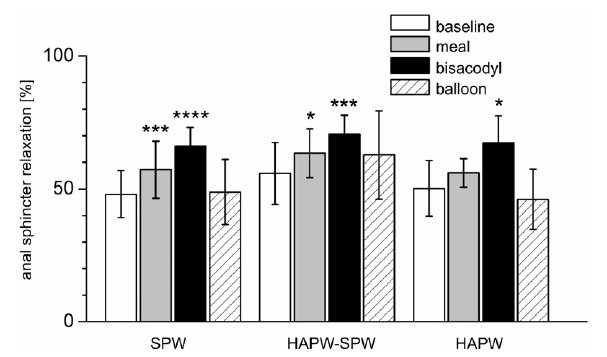
FIGURE 6 | Relaxation of the anal sphincters associated with different motor patterns and in different conditions. Shown is the relaxation of the anal sphincter as a percentage of the anal sphincter pressure just prior to the motor patterns indicated on the X axis. ∗ P < 0.05; ∗∗∗ P < 0.01; ∗∗∗∗ P <